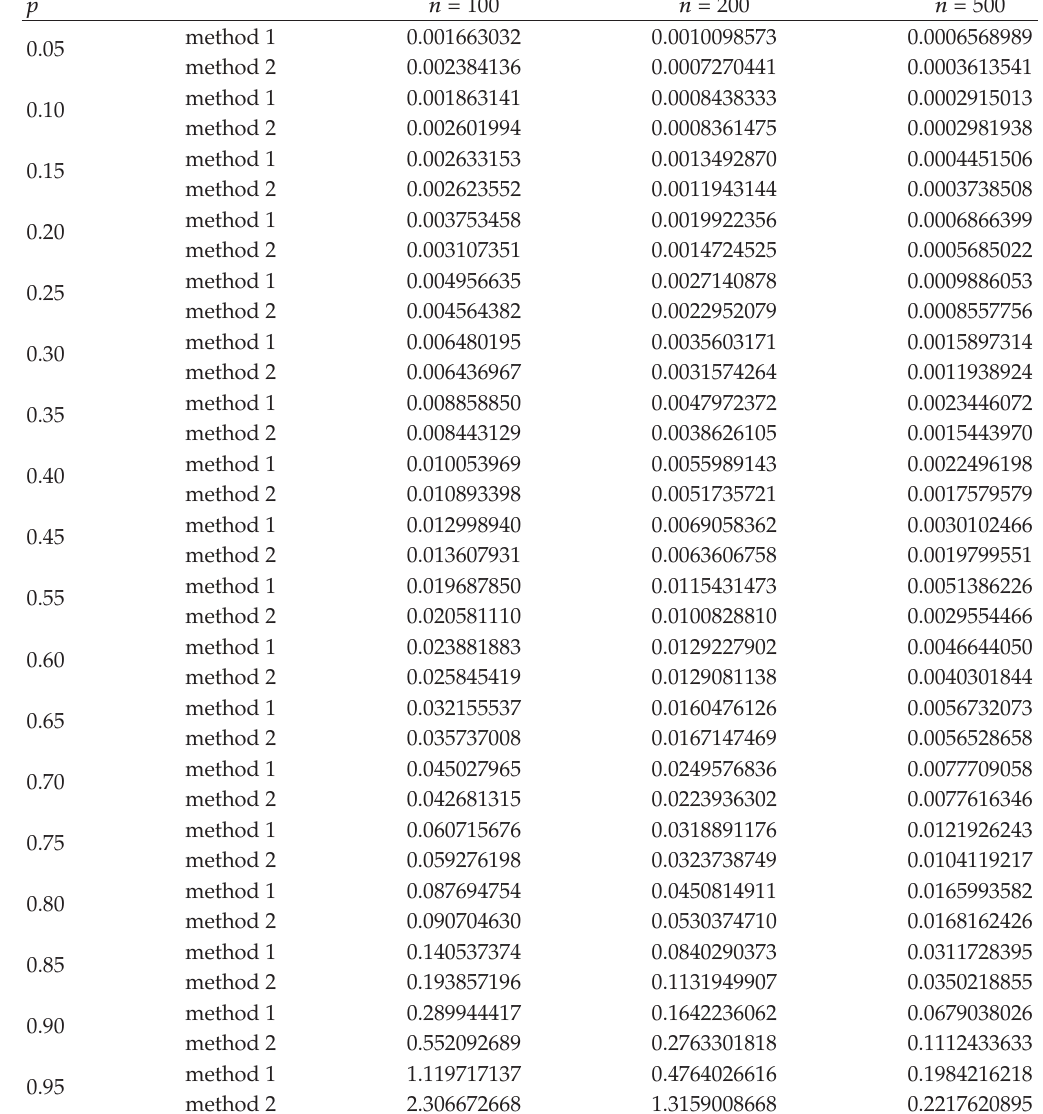
Table 3: Mean squared errors results for bandwidth selection methods for di ff erent sample sizes and for data from a Log-normal